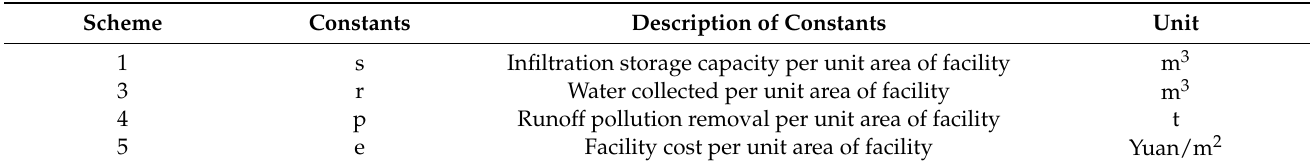
Table A1. Constants implications of multi-objective optimal combination models for sponge facilities.